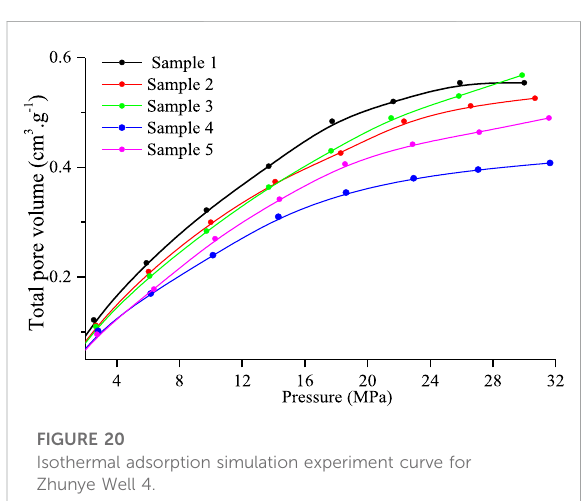
FIGURE 20 Isothermal adsorption simulation experiment curve for Zhunye Well